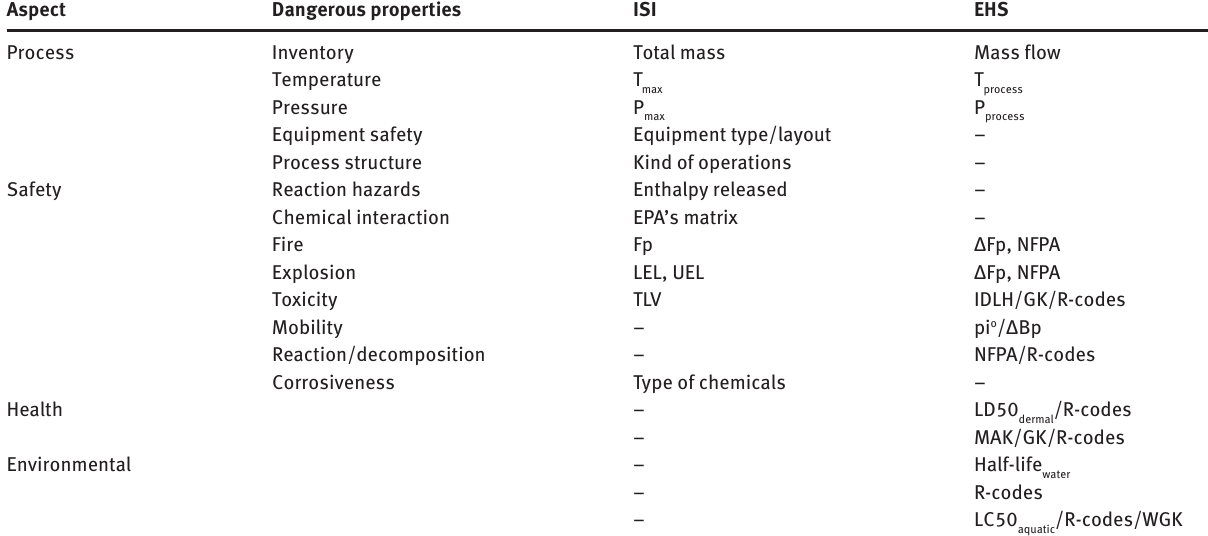
Table A1 Basic settings of the ISI and the EHS